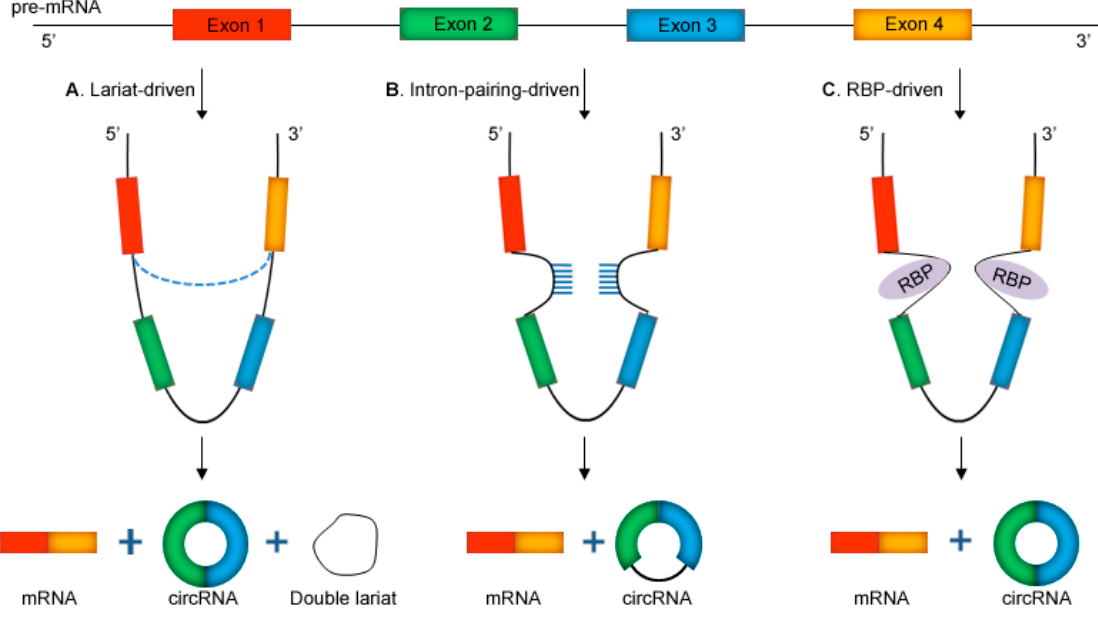
Figure 1. Biogenesis of circRNAs. ( A ) Lariat-driven model; ( B ) intron-pairing-driven model; ( C ) RNA-binding proteins (RBP)-driven